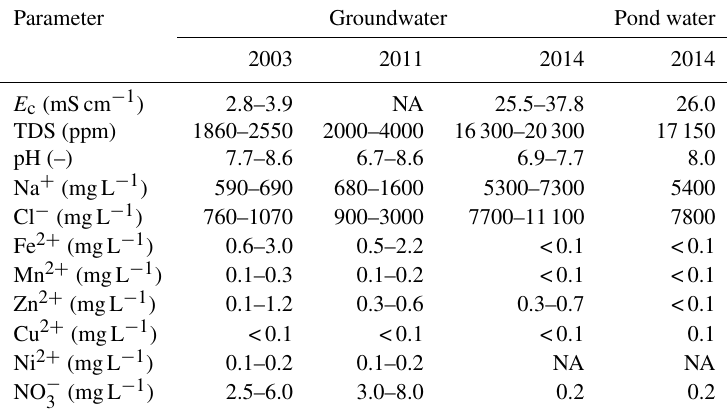
Figure 3. Landsat images showing the time evolution of the farmland (blue lines) and the pond in Nubariya between 1984 and 2014. The extent of desert reclamation is illustrated with reference to the red line, which marks the contemporary (2014) extent of the irrigated area. The Landsat images are available from the US Geological Survey. Table 1. Chemical analyses of groundwater samples collected in 2003 (after Sharaky et al., 2008) and 2011 (after Masoud, 2014) and groundwater and pond water samples collected in 2014 within the IMPROWARE project ∗